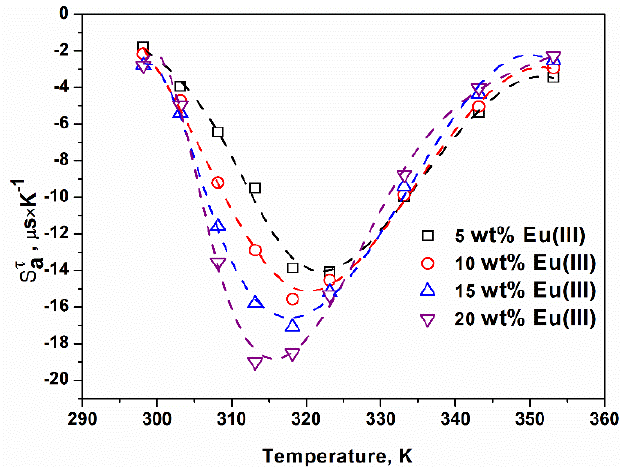
Figure 5. The absolute sensitivity of the luminescence intensity in PLA composite films doped with a different content of the Eu(III) complex as a function of temperature at λ ex = 340 nm and λ em = 613 nm (marker symbols—experimental data, dashed lines—approximations).